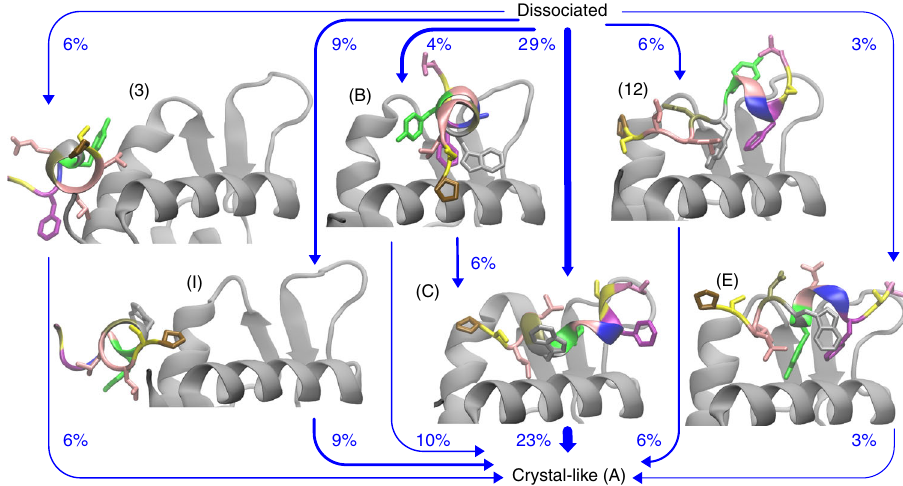
Fig. 3 Binding mechanism comprised by the 60% most probable pathways. Structures of metastable (on-pathway) intermediates are shown, labels are as in Fig. 1. Arrows indicate the direction and relative magnitude of the reactive fl ux from the dissociated state to the crystal-like bound state. PMI residues that form PMI – Mdm2 contacts with at least a probability of 0.5 in a given macro-state are shown as